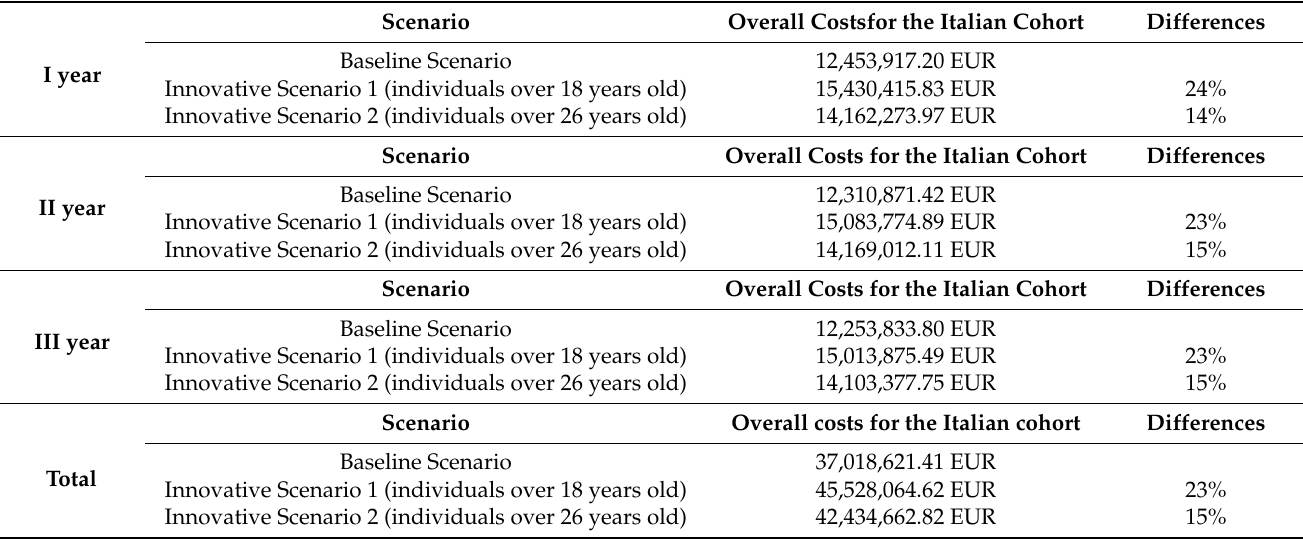
Table 6. Budget impact analysis at national (Italian) level not considering the CAR-T cost of the